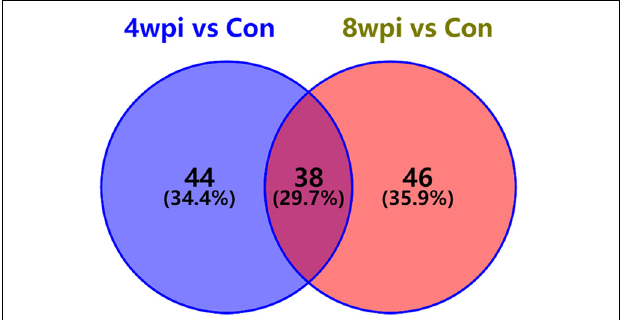
FIGURE 5 | Venn diagram displaying the common and unique metabolites among the two infection groups vs control group. There were 38 significantly differential metabolites were shared in two infected groups. 4 wpi vs con, 4 wpi group vs control group; 8 wpi vs con, 8 wpi group vs control